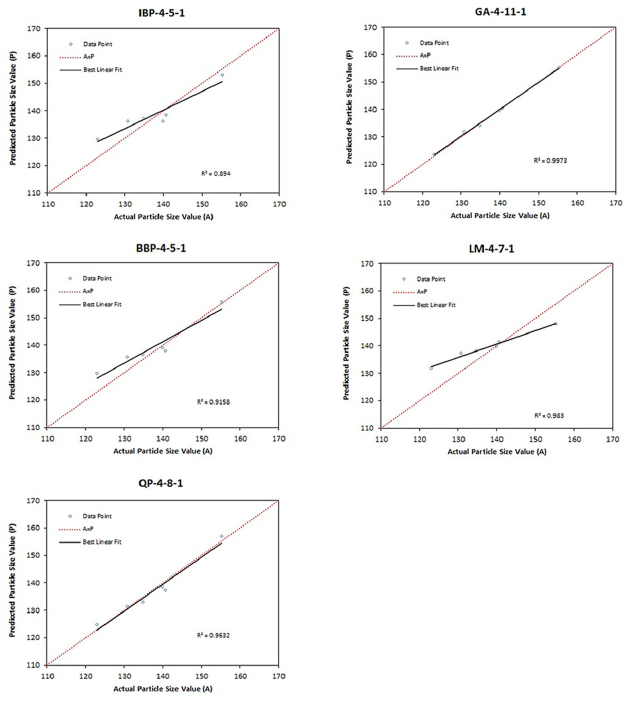
Fig 2. Scatter plot of predicted particle size (nm) values versus actual conversion (%) values by using five algorithms for the testing data set.